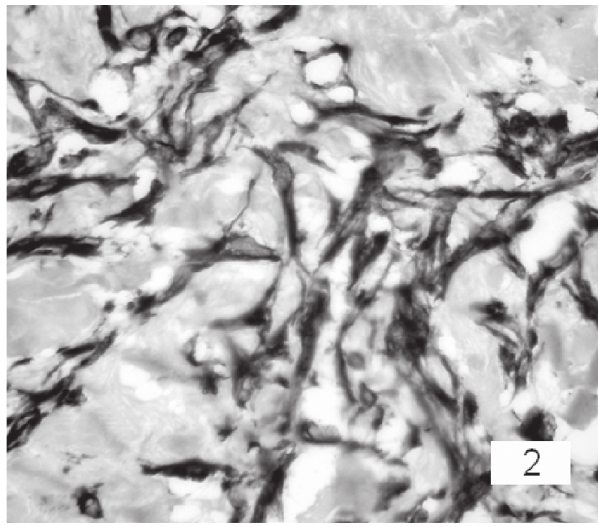
Figure 1. Histology of fibromatosis of the male breast showing a proliferation of spindle cells with moderate cellularity and an edematous background (hematoxylin-eosin, original magnification x200).